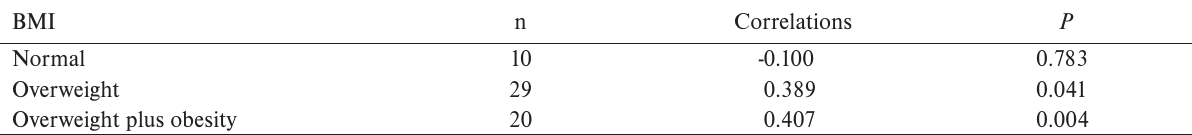
Table 2. Correlations (Spearman‘s) between epicardial fat and A-FABP depending on